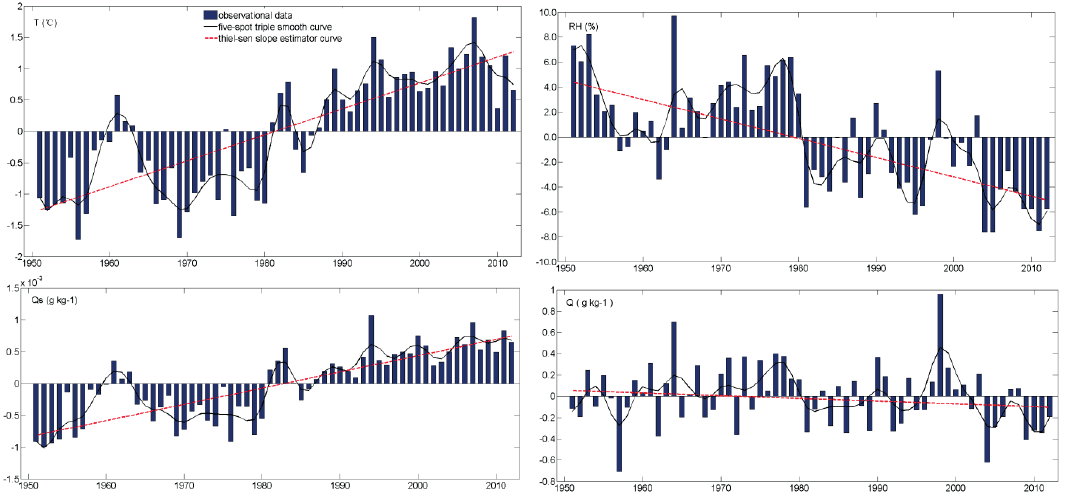
Fig. 2 Trends of surface humidity and temperature based on daily observations from Beijing Meteorological Station during